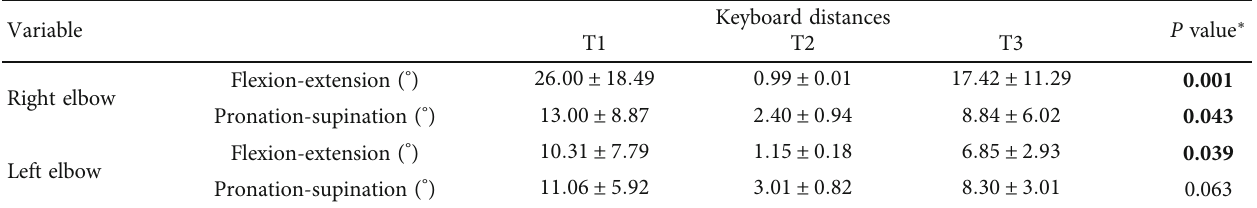
Table 2: Mean ROM ± SD values of the elbow fl exion-extension and pronation-supination in three distances of the keyboard ( ° ). Variable